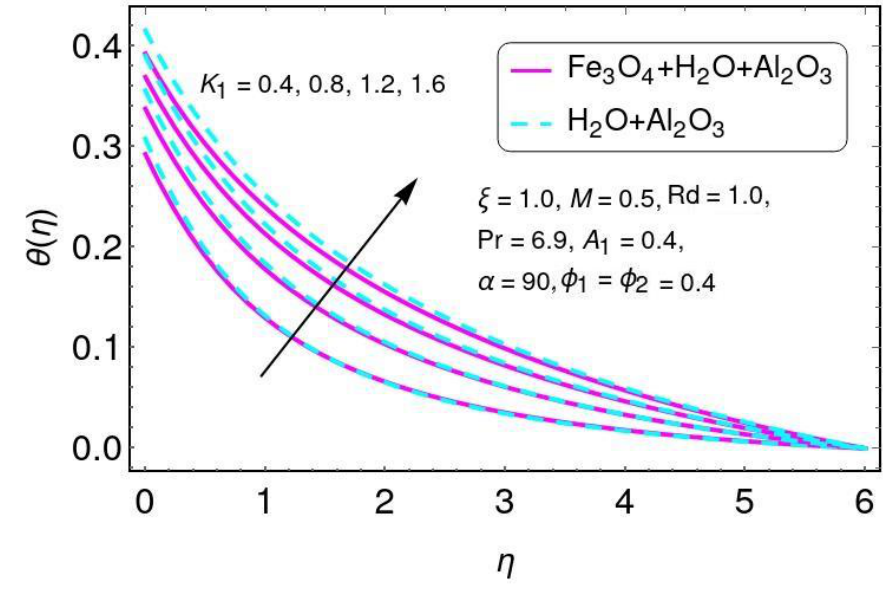
Figure 13. The properties of K 1 on the temperature